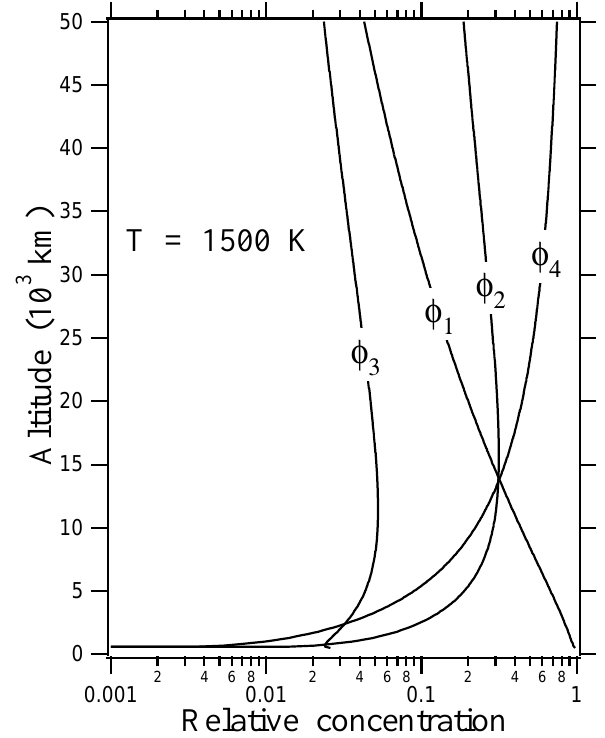
Fig. 14. Vertical distribution of the relative abundance of the four types of particles theoretically possible for atomic hydrogen with an exospheric temperature of